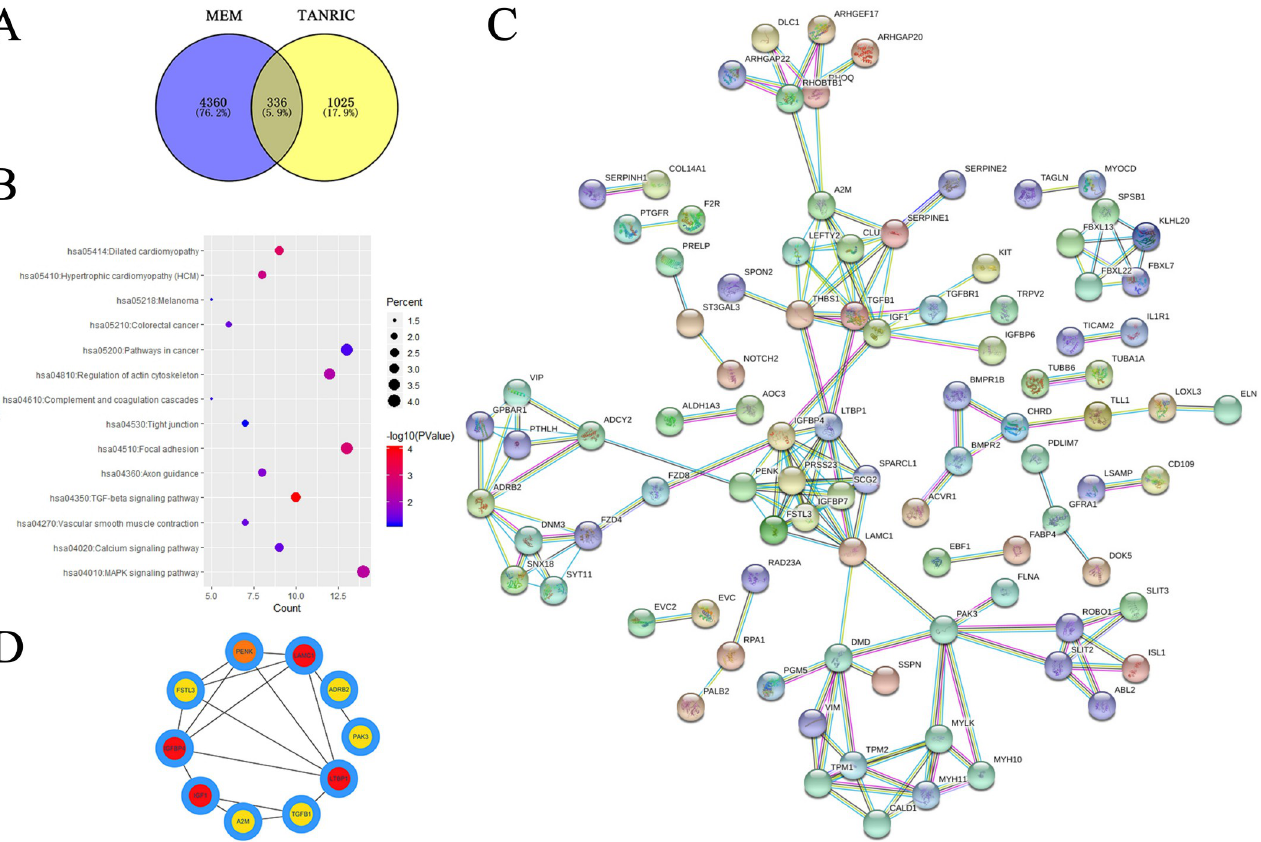
Fig 2. Enrichment analysis of genes related to LINC00922 in gastric cancer. (A) Venn diagram of the overlapping genes predicted by the MEM database and TANRIC. (B) KEGG pathway enrichment analysis by DAVID. (C) Protein-protein interaction network of genes related to LINC00922. (D) Top ten hub genes of